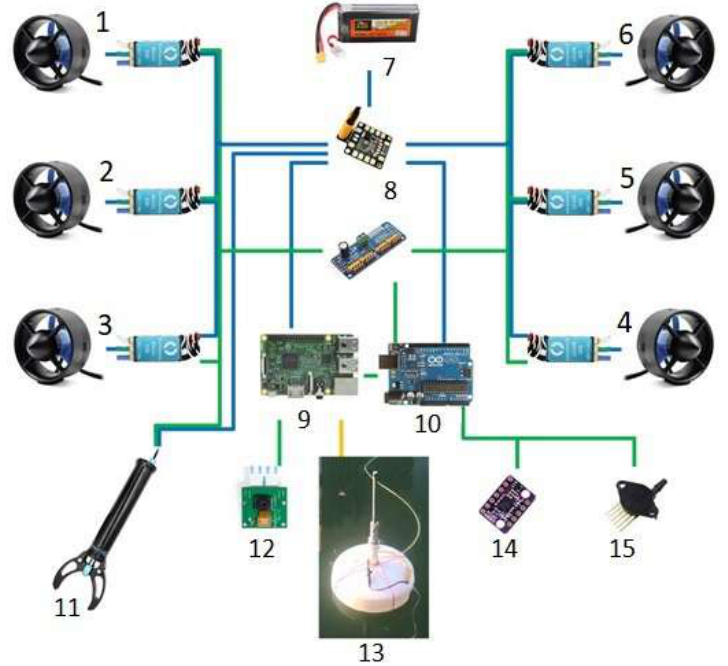
Figure 2. An unmanned multi-functional underwater